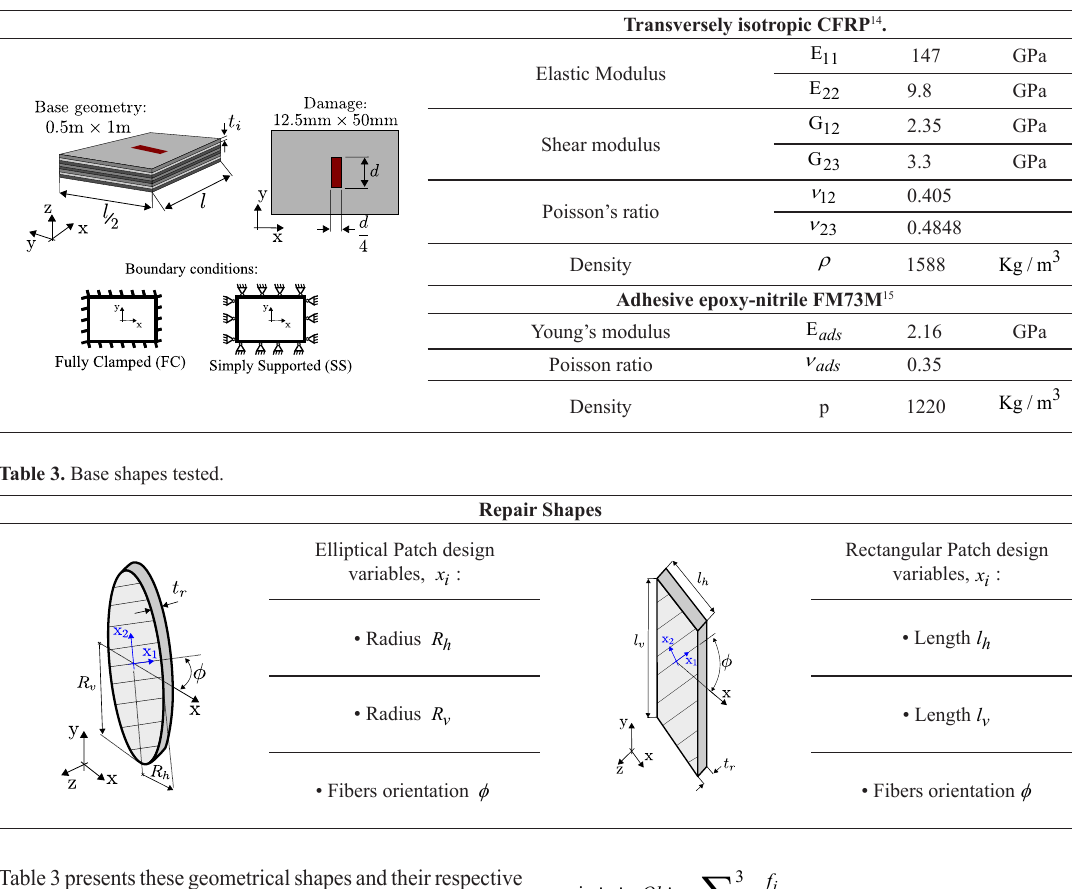
Table 2. Laminate mechanical properties.